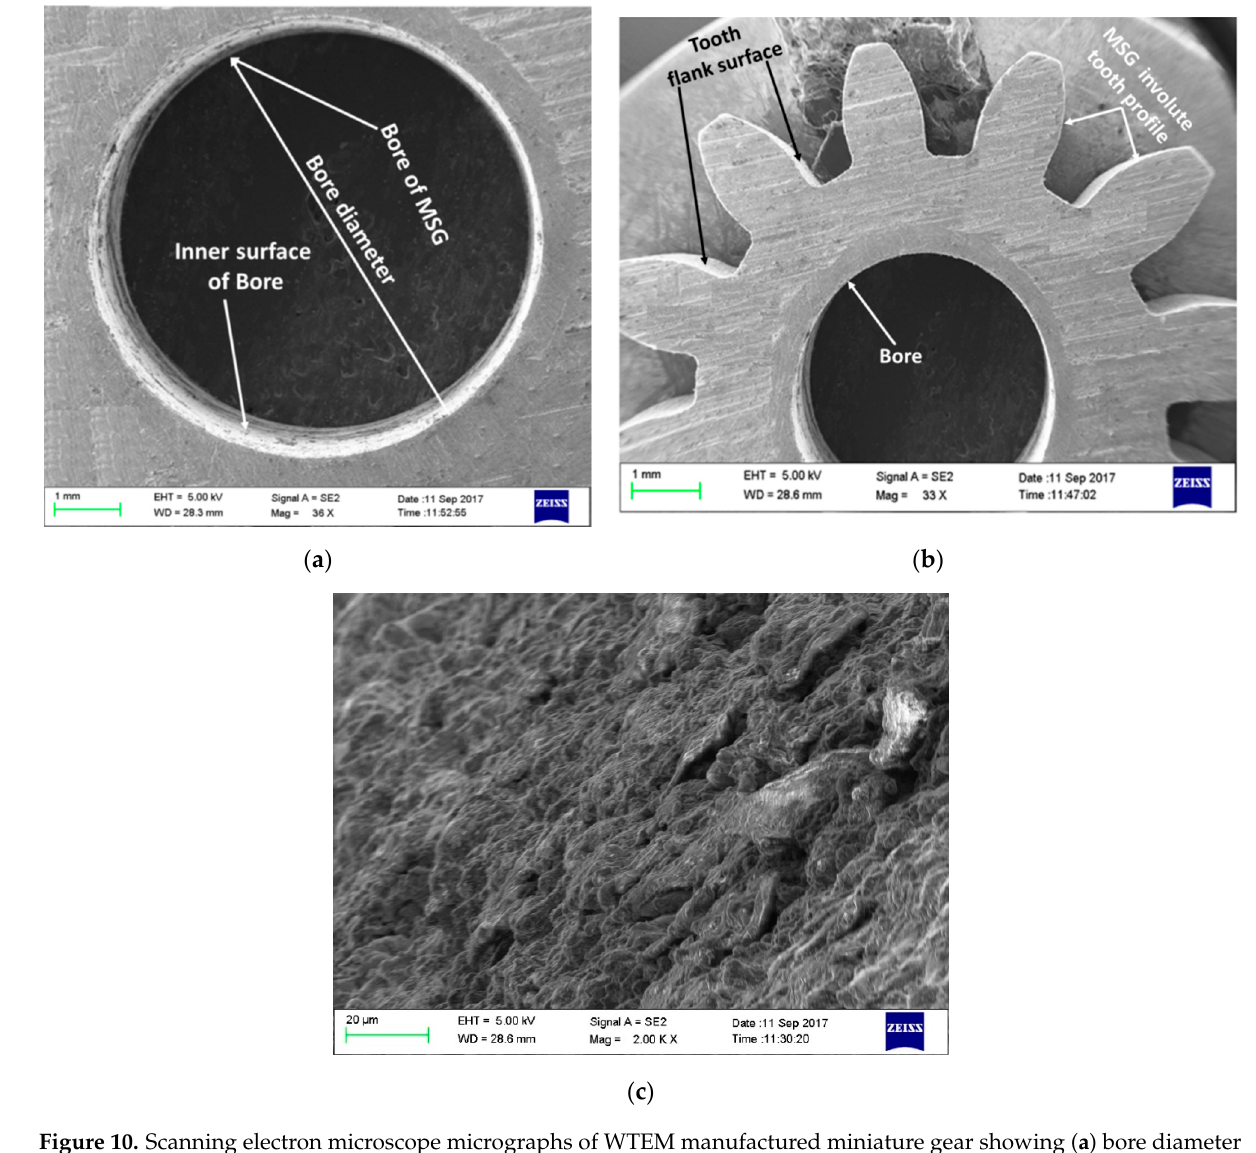
Figure 10. Scanning electron microscope micrographs of WTEM manufactured miniature gear showing ( a ) bore diameter free from burr and sharp edges on both top and bottom side; ( b ) uniform and accurate tooth profile and burr-free edge definition; and ( c ) microstructure of tooth flank surface.